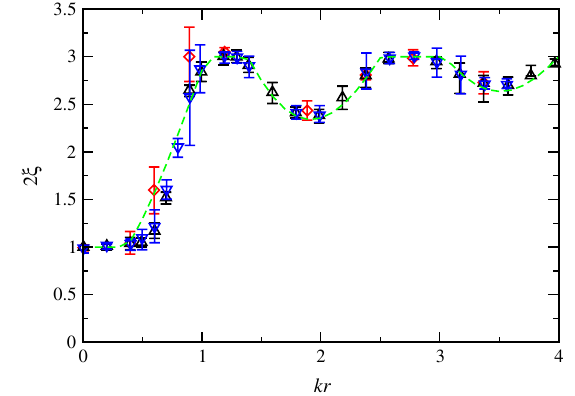
FIG. 9. The anomalous diffusion exponent h x 2 i ∼ t 2 ξ versus the high-frequency control parameter kr defined in the text. The triangles and diamonds are simulation results from Fig. 1 in Ref. [2] with U 0 ¼ 200 E (with varying photon scattering rate; r see details in Ref. [2]). The curve is the theory, Eqs. (7) and (80), with a renormalized U 0 as explained in the text with c ¼ 34 . 7 . The transition between normal 2 ξ ¼ 1 , Lévy 1 < 2 ξ < 3 , and Richardson 2 ξ ¼ 3 behaviors is clearly visible, and as shown by Wickenbrock et al. , it is controlled by the high-frequency